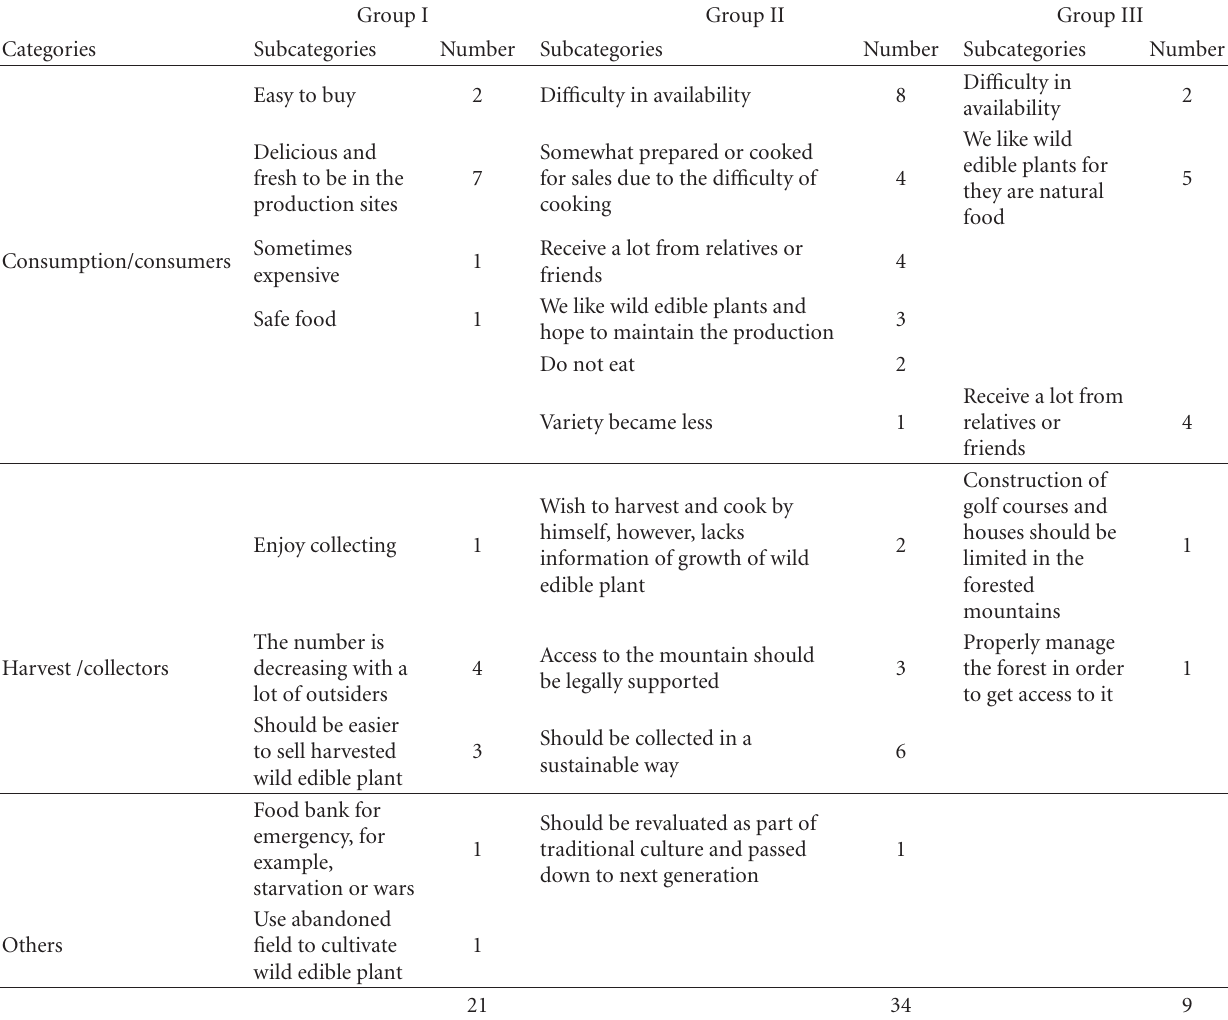
Table 8: Summary of respondents’ concern towards consumption and harvest of edible wild